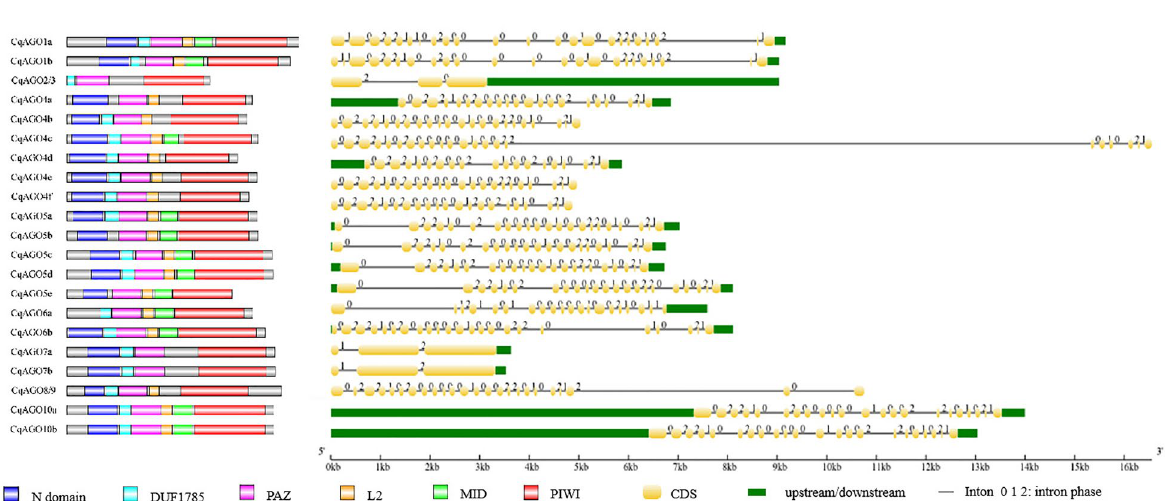
Figure 2. Conserved domains of CqAGO proteins identified by SMART and Pfam, generated using IBS (left). The protein domains include N domain, DUF1785, PAZ, L2, MID, and PIWI. Introns in CqAGO genes are shown on the